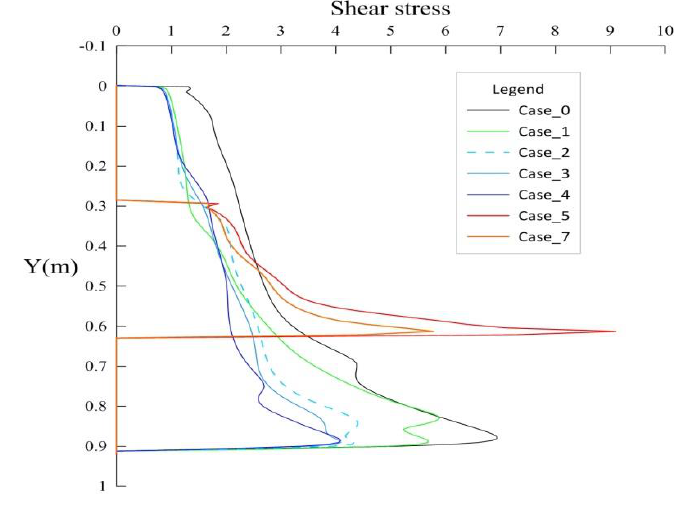
Figure 15. Bed shear stress for different cases.